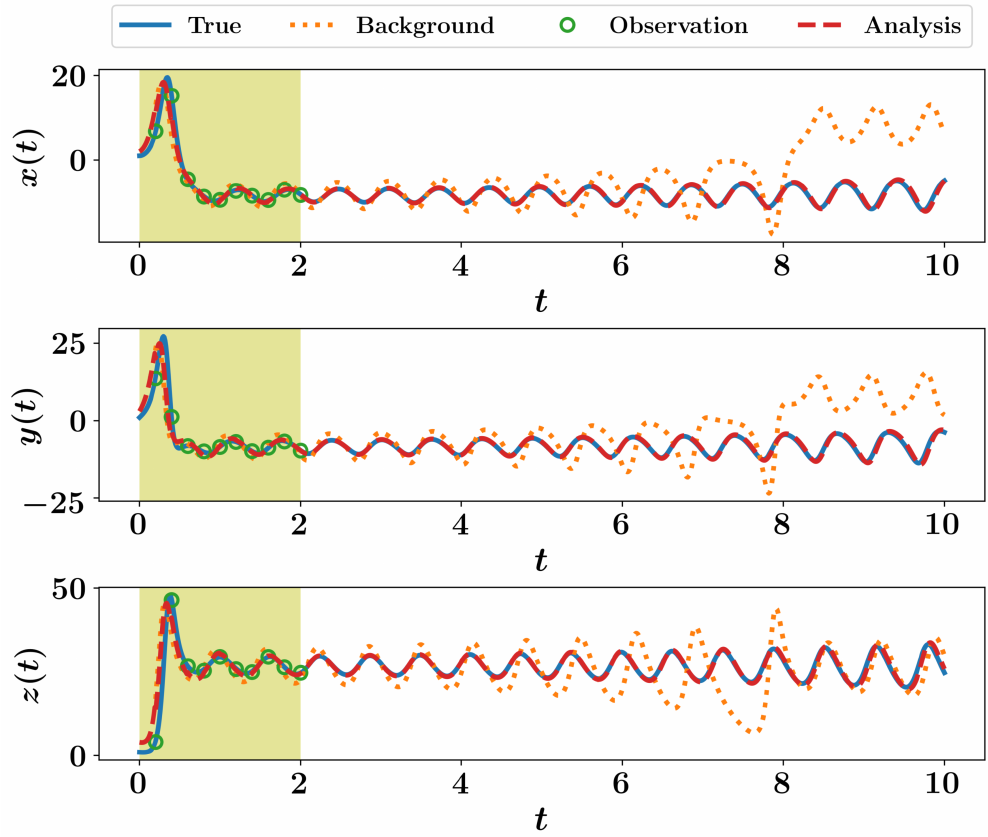
Figure 1. Results of 3DVAR implementation for the Lorenz 63